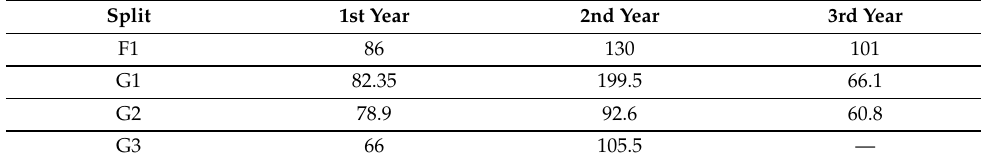
Table 7. Average annual precipitation per field (in